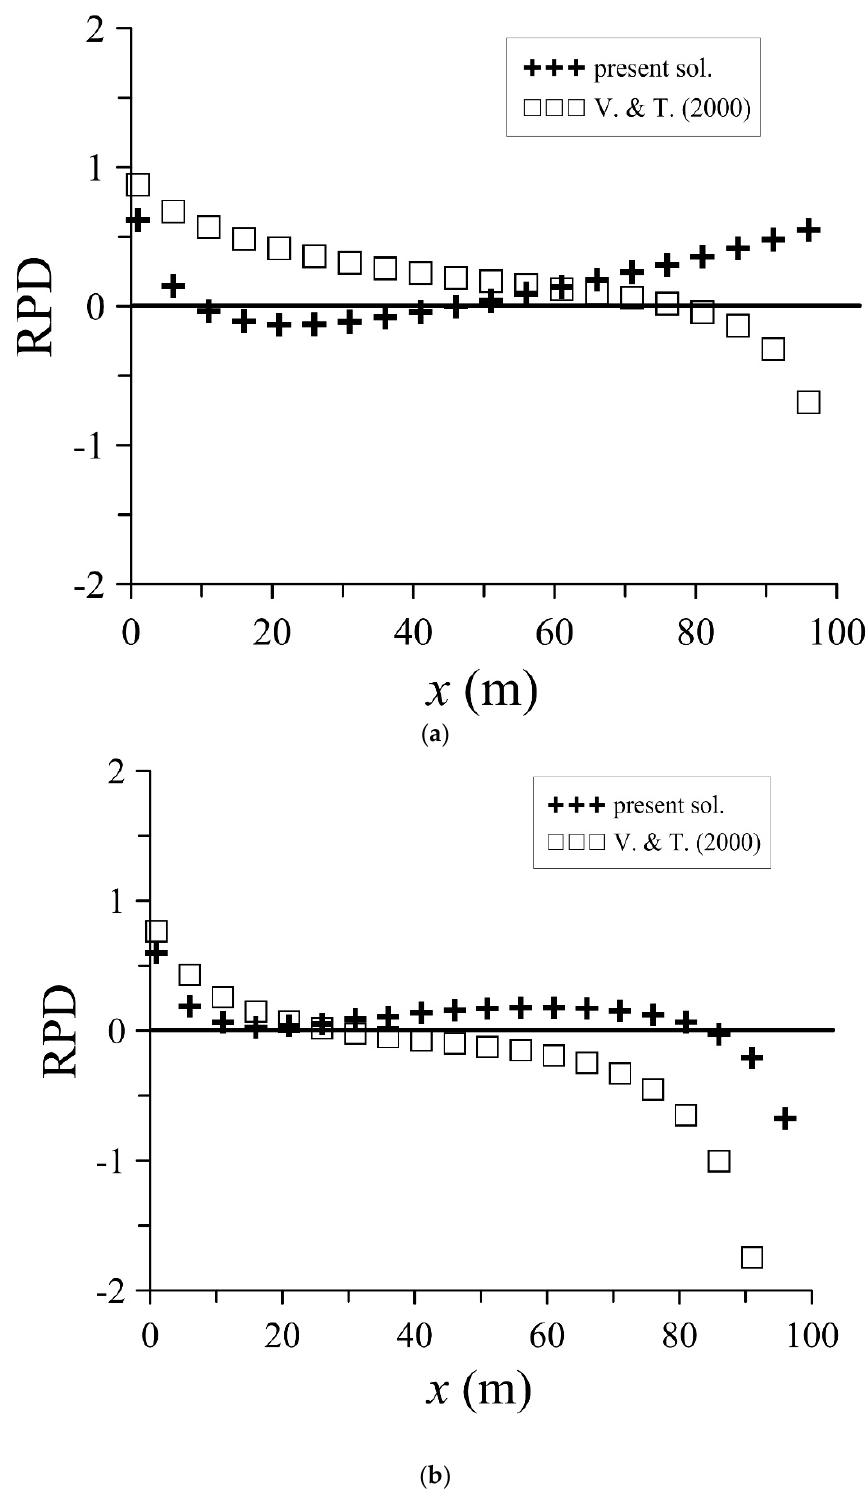
Figure 7. RPD between analytical and numerical solutions. ( a ) 𝜃 = 2° ( b ) 𝜃 = 6° ( t = 5 days).